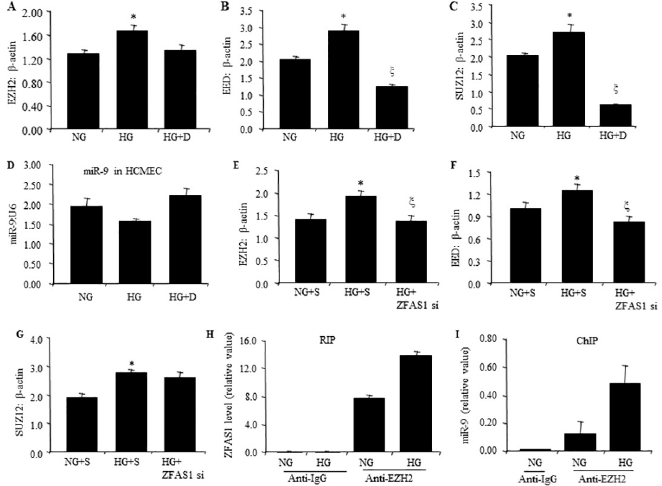
Fig 3. ZFAS1–PRC2 complex interaction regulating miR-9 expression in vitro in HCMEC. Treatment of HCMECs with methylation inhibitors (DZNep) reduced HG induced mRNA upregulation of (A, B, C) EZH2, EED and SUZ12. In conjunction, DZNep also corrected HG induced decreased (D) miR-9 levels. Interestingly, transfection of HCMECs with ZFAS1 siRNA reduced HG induced (E, F) upregulation of EZH2 and EED mRNA, whereas(G) SUZ12 mRNA remained unchanged. (H) RIP assay using anti-EZH2 antibody performed in HCMECs showed glucose-induced increased binding of ZFAS1 with EZH2 (anti-IgG as negative control). (I) ChIP assay demonstrated increased binding of EZH2 on miR-9 promoter as measured by RT-PCR. (NG = 5 mM glucose; HG = 25 mM glucose; RIP = RNA immunoprecipitation; ChIP = chromatin immunoprecipitation RNA; D = DZNep; data expressed as a ratio to β -actin, mean ± SEM; � P < 0.05 compared to NG; ξ < 0.05 compared to HG; n = 6/group).